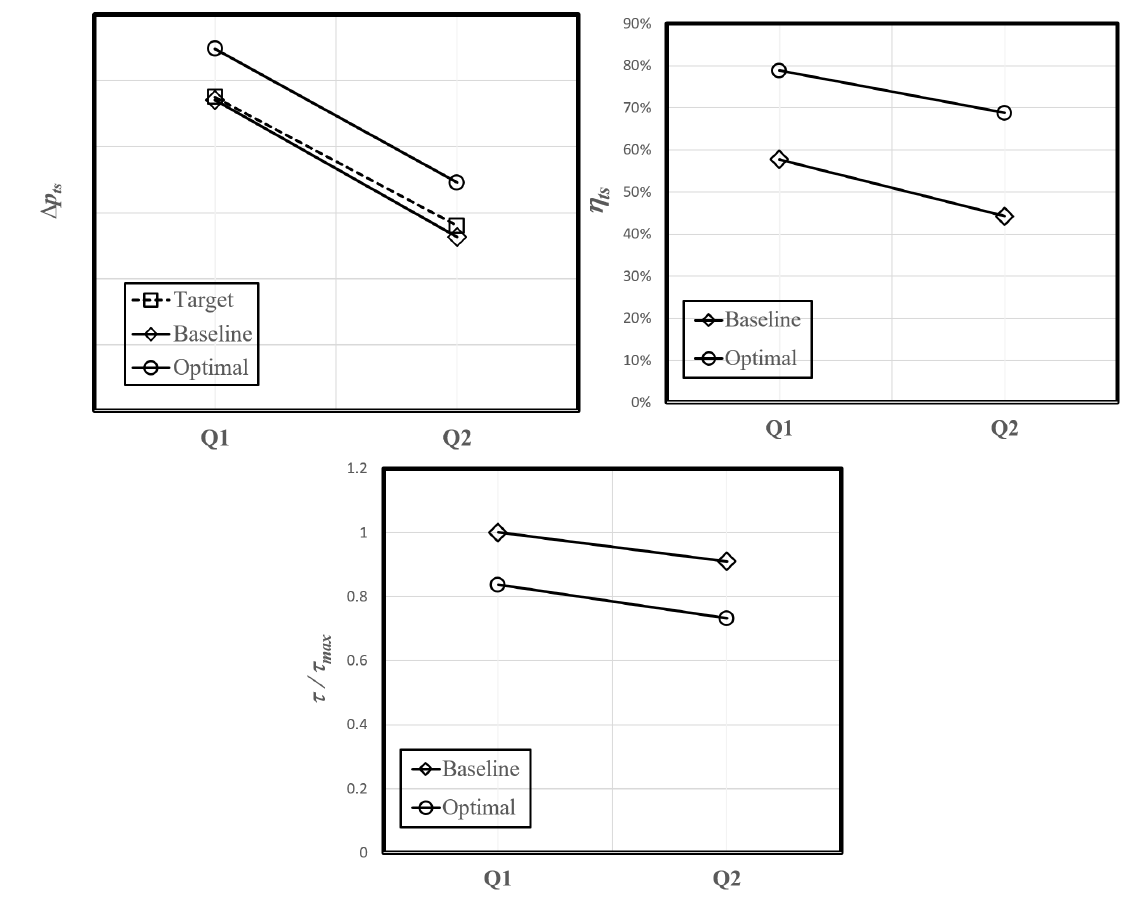
Figure 12. Comparison of CFD results for baseline and optimal design.